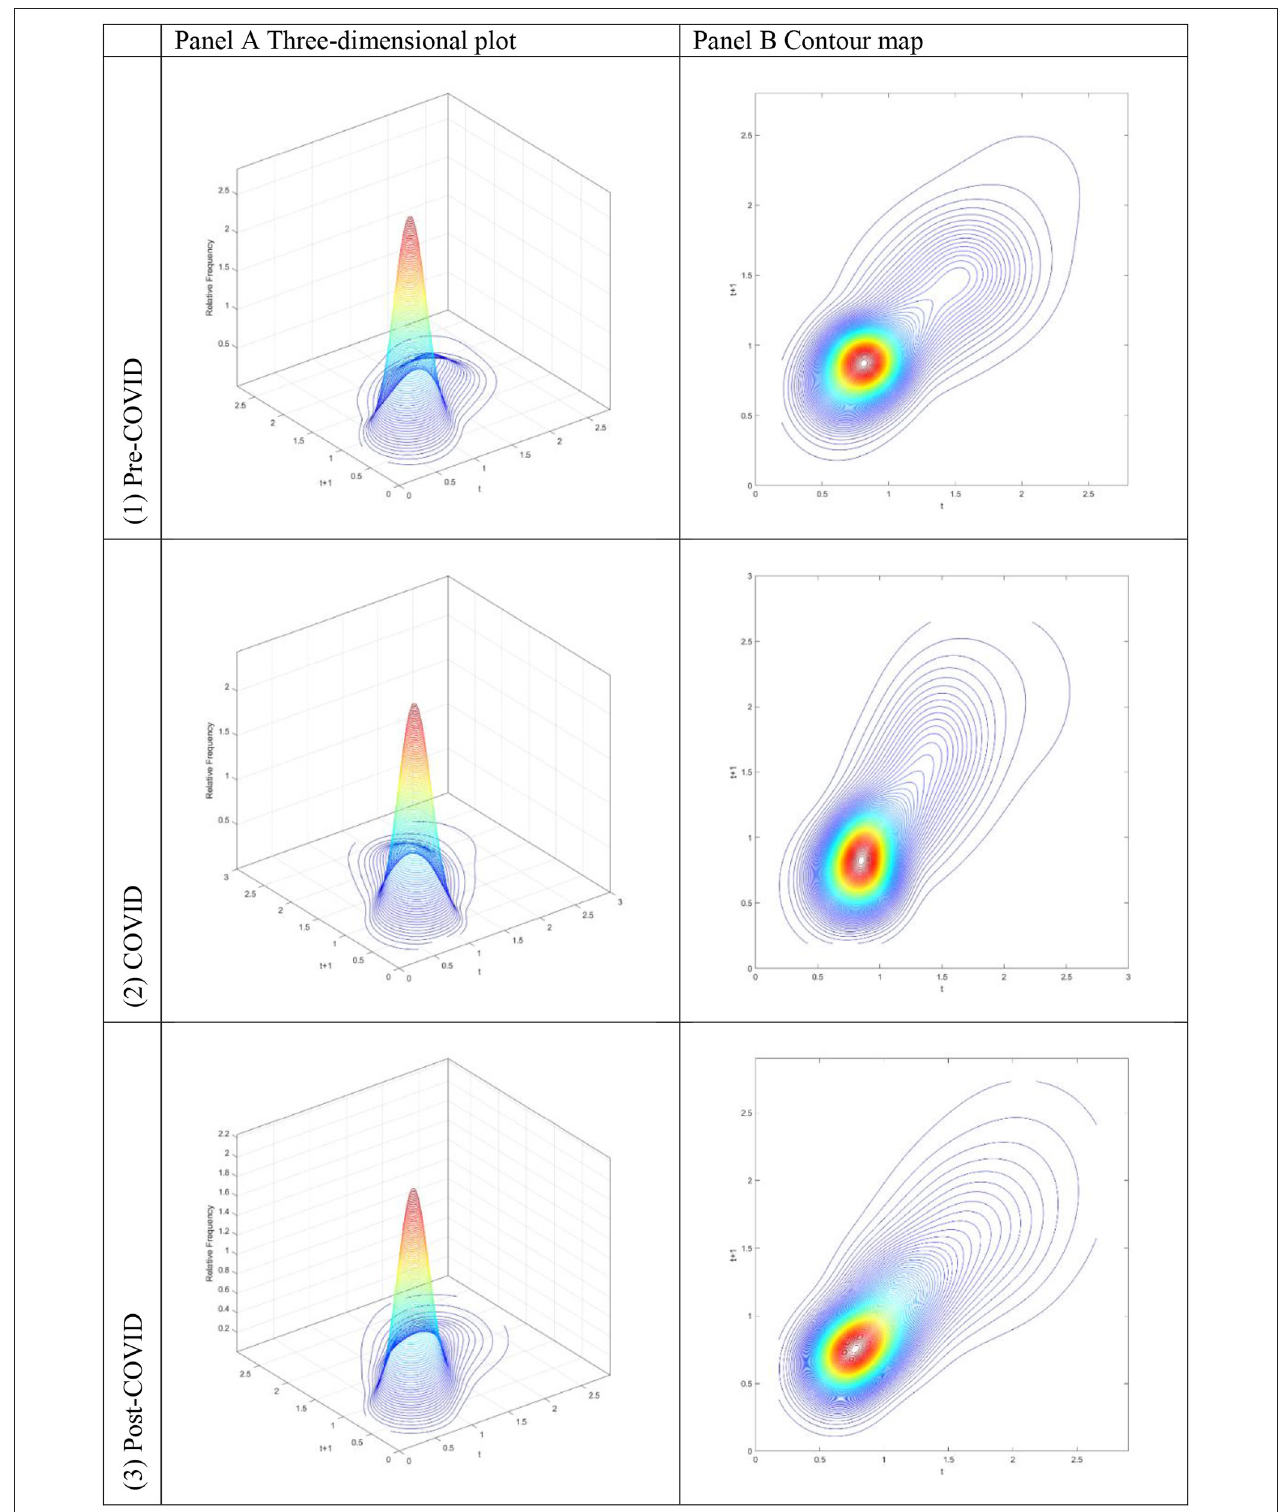
FIGURE 1 | Three-dimensional plot (A) and Contour map (B) of transition probability kernel for the RDIPC of all residents in cities with the longest duration of Level I ERS with quarterly transitions during the (1) Pre-COVID, (2) COVID, and (3) Post-COVID periods. Source: authors’ calculation.